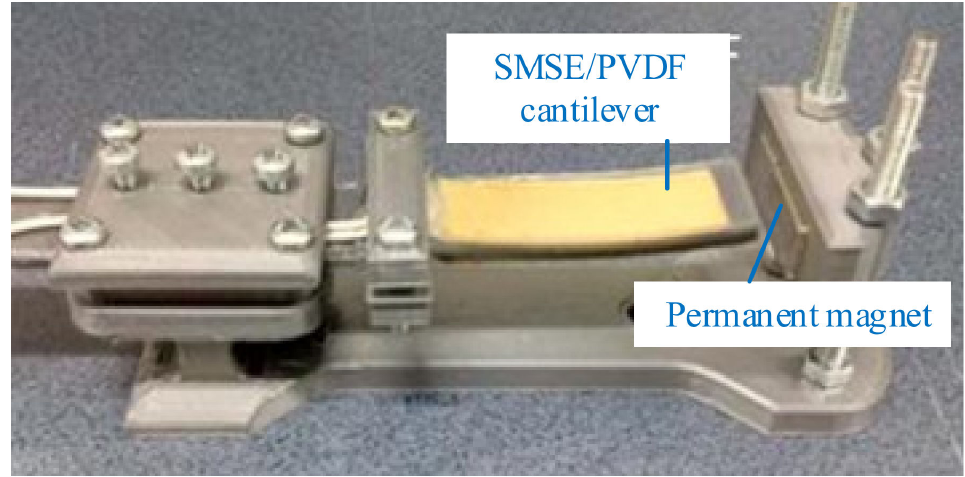
Figure 1. A soft magneto-sensitive elastomer (SMSE) harvester (reproduced with permission from [104]; published by IOP,